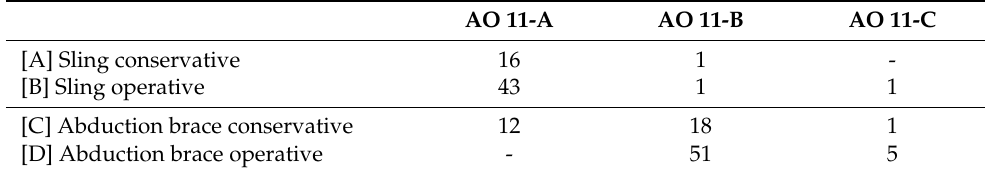
Table 1. Distribution of the participants in the four groups according to fracture